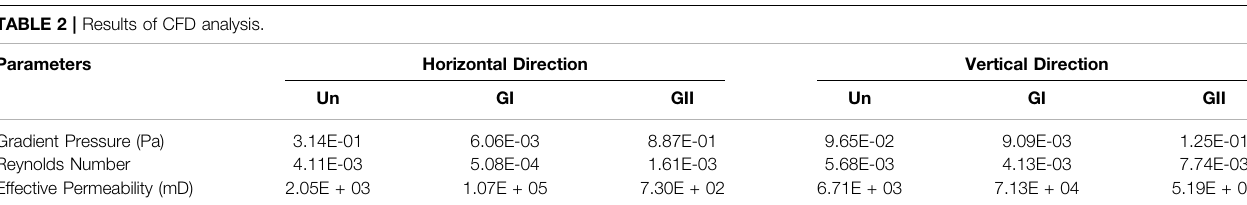
TABLE 2 | Results of CFD